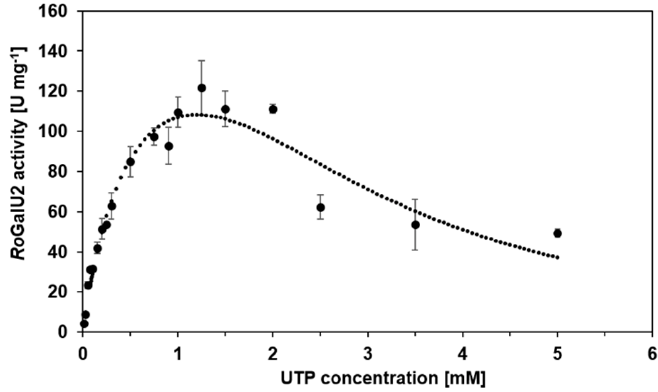
Figure 9. Ro GalU2 enzyme activity depending on the UTP concentration between 10 µM and 5 mM at a fixed glucose 1-phosphate concentration of 250 mM. Fit is calculated by the Model of Yano and Koga [50], for enzyme kinetics with substrate inhibition. The assay mixture contained 0.01–5 mM UTP, 250 mM glucose 1-phosphate, 1 mM MgCl 2 , 50 mM Hepes buffer, pH 7.4, 1.7 µg Ro GalU2. Reaction was carried out at 42 °C in 1 mL volume. Mean values with standard deviations from triplicates are shown.